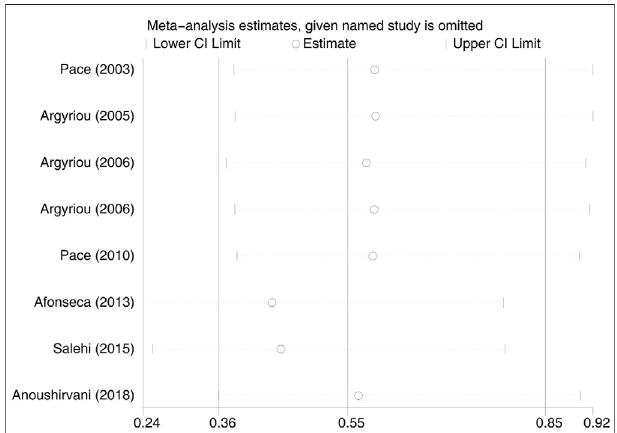
FIGURE 5 | Sensitivity analysis of the incidence of all-grade CIPN in VE and control groups. VE, vitamin E; CIPN, chemotherapy-induced peripheral neuropathy.